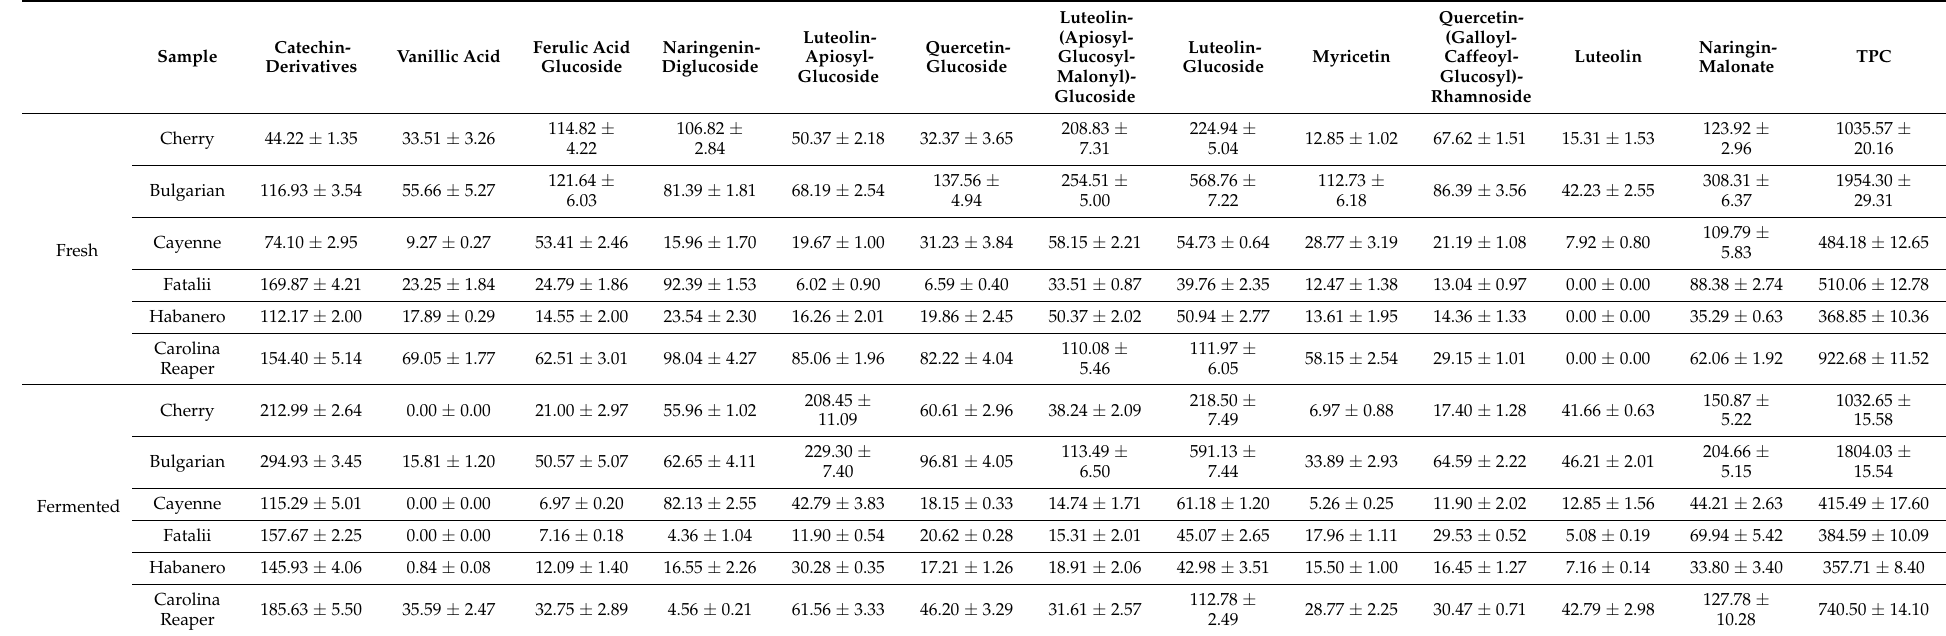
Table 6. Content of phenolic compounds before and after fermentation ( µ